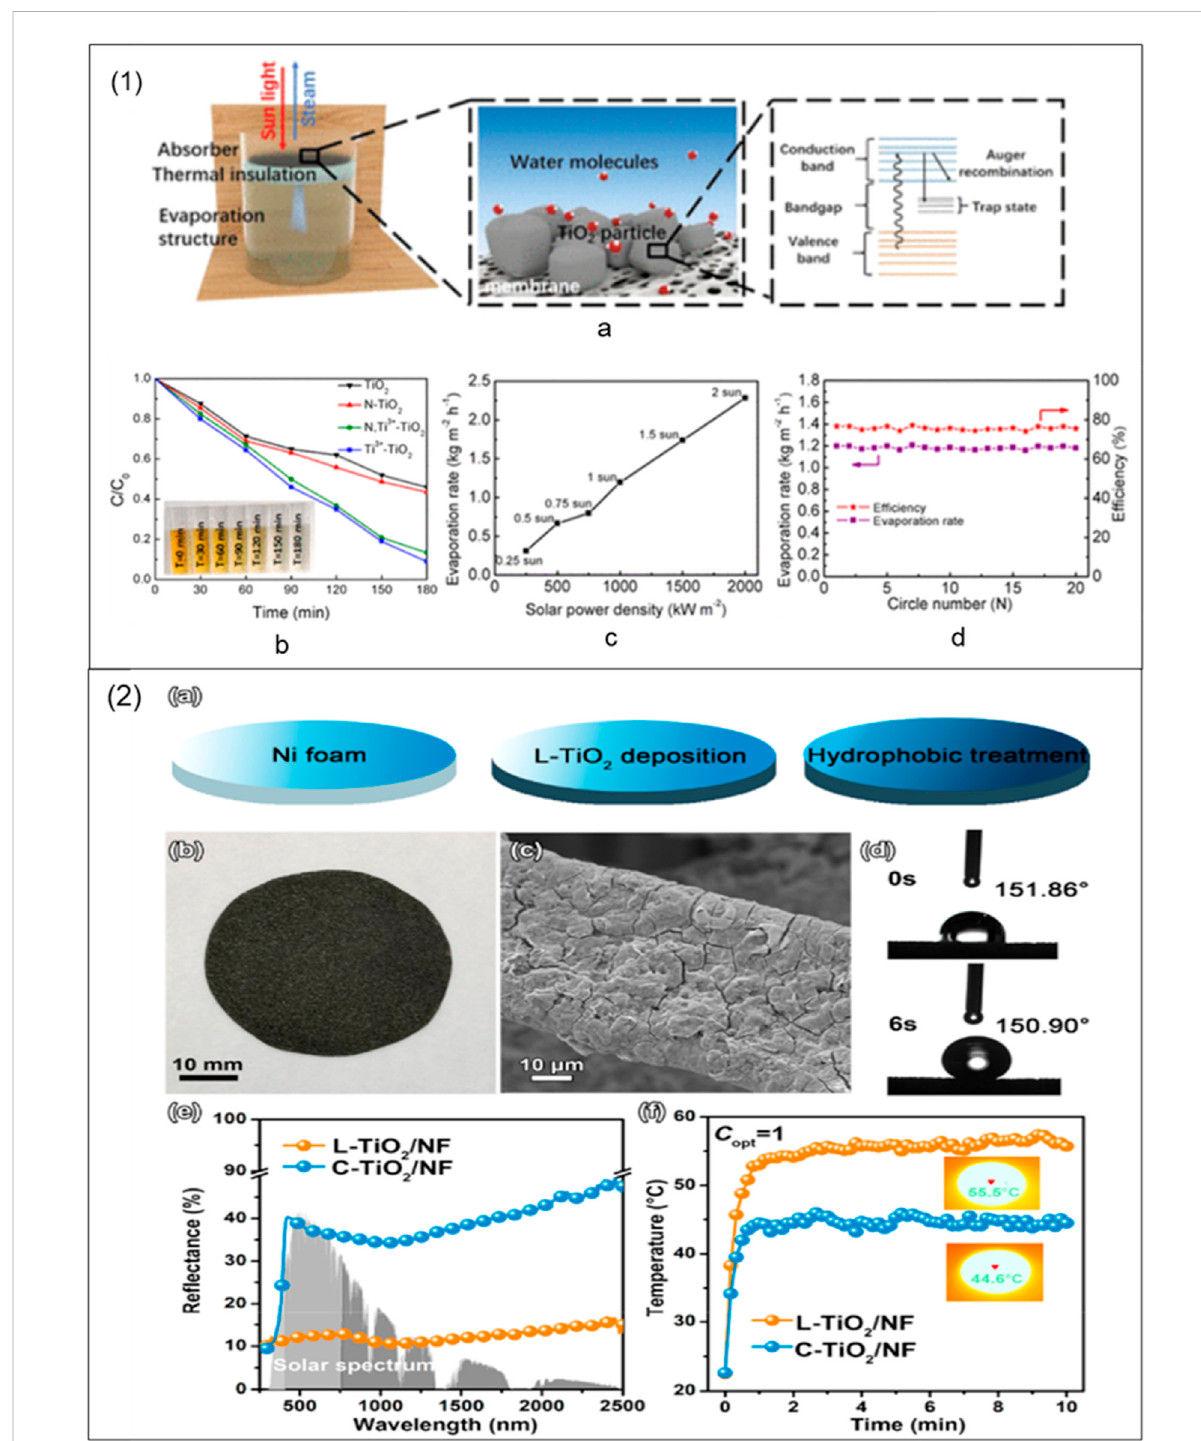
FIGURE 4 (1) (a) Schematic diagram of the proposed mechanism for solar-driven interfacial evaporation of semiconductor materials. (b) Photocatalytic activity of different samples under xenon lamp irradiation with time. (c) Evaporation rates under irradiation by different light intensities. (d) Measured recycle performance of Ti 3+ -TiO 2 (Ying et al., 2020); Reproduced with permission. Copyright 2020 American Chemical Society. (2) (a) Schematic diagramofthepreparationofanL-TiO 2 /NFevaporator. (b) Photographand (c) SEMimageofL-TiO 2 /NF. (d) Masschangeofwaterasafunction of irradiation time with different structures under 1 Sun irradiation. Diffuse re fl ectance spectra of L-TiO 2 /NF and C-TiO 2 /NF. Along with solar spectrum at the background (f) Surface temperature vs time plots for L-TiO 2 /NF and C-TiO 2 /NF exposed to one sun ’ s worth of radiation. The relevant temperature distribution pictures at steady state are shown in the insets. (Chen et al., 2020); Reproduced with permission. Copyright 2020 American Chemical